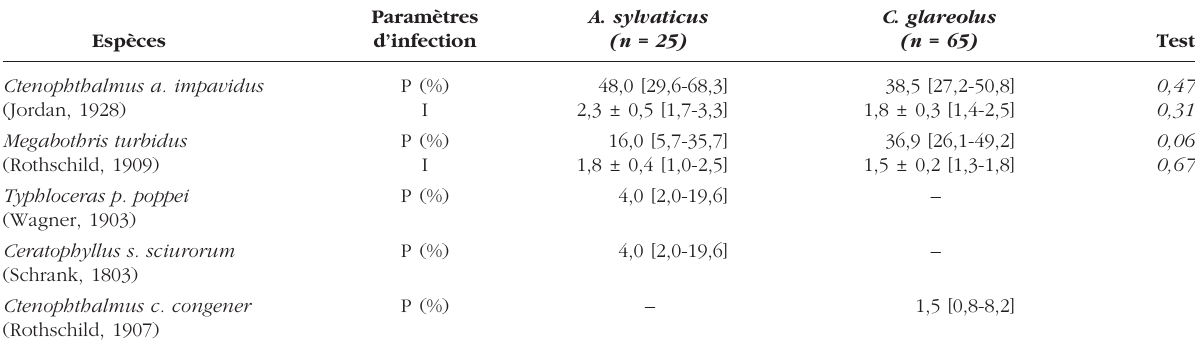
Tableau I. – Prévalence (P, et intervalle de confiance à 95 %) et intensité moyenne (I, et intervalle de confiance à 95 %) des espèces de puces collectées sur les mulots sylvestres et campagnols roussâtres capturés entre mars et décembre 2005 en Forêt de Sénart. Test exact de Fisher pour les prévalences, test-t “bootstrapé” pour les intensités.